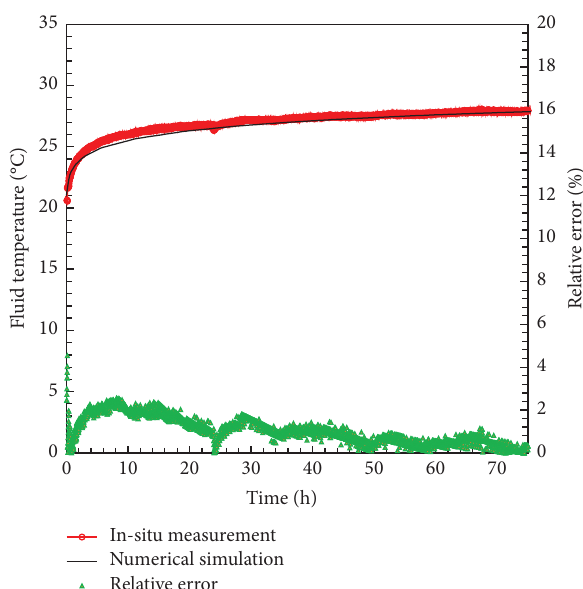
Figure 4: Comparison between the numerical simulation and in-situ measurement.